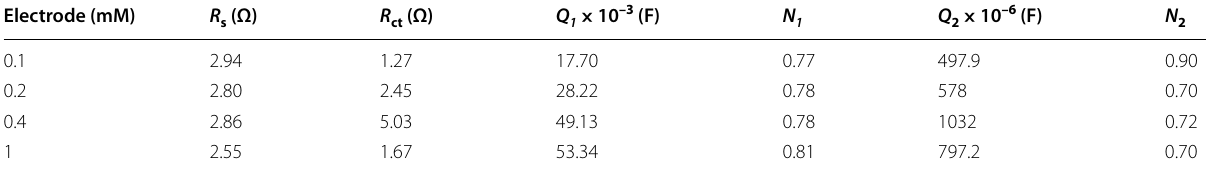
Table 2 Fitting data of equivalent circuit elements obtained by the frequency response Electrode (mM) R s